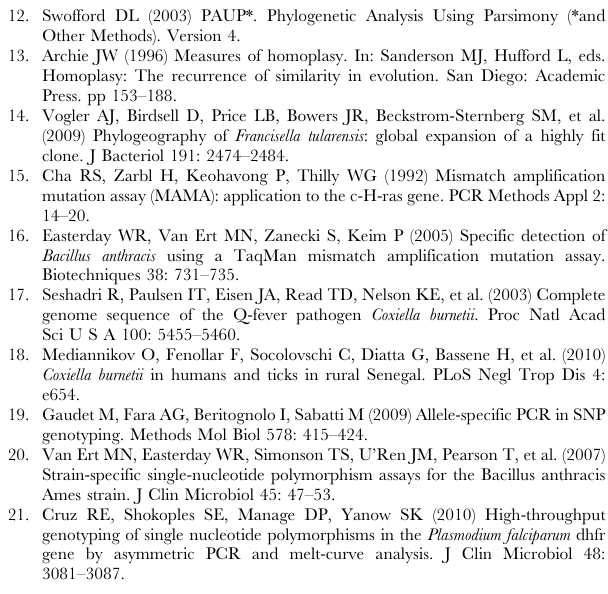
Table S1 Phylogenetic characterization of the 112 polymorphisms from MST sequence comparisons. a Lo- cus name is given as the MST locus followed by the base position in the alignment (Fig. S1). b Branch indicates the phylogenetic location(s) of each polymorphism on the phylogenetic tree (Fig. S2). c Locus type describes the nature of the polymorphism: bi- allelic SNP, tri-allelic SNP or indel; autapomorphies are also indicated. d This locus was not homoplastic based on in silico analyses but was found to be homoplastic for a single sample when assayed against the entire panel of DNA (see text). e Assays presented in this work. Table S2 Epidemiological and results data for samples used in this study. a Expected MST genotype based on overlap of samples with Glazunova et al. [7] (denoted with b ) or from in silico analysis of whole genome sequences from this work (denoted with c ). Samples with a listing of n/a were not reported in Glazunova et al. [7] (based on a comparison of sample name alone) nor had whole genome sequence available for in silico analysis. Thus we could not predict the genotype based on other studies. d Observed MST genotype(s) based on the results from 14